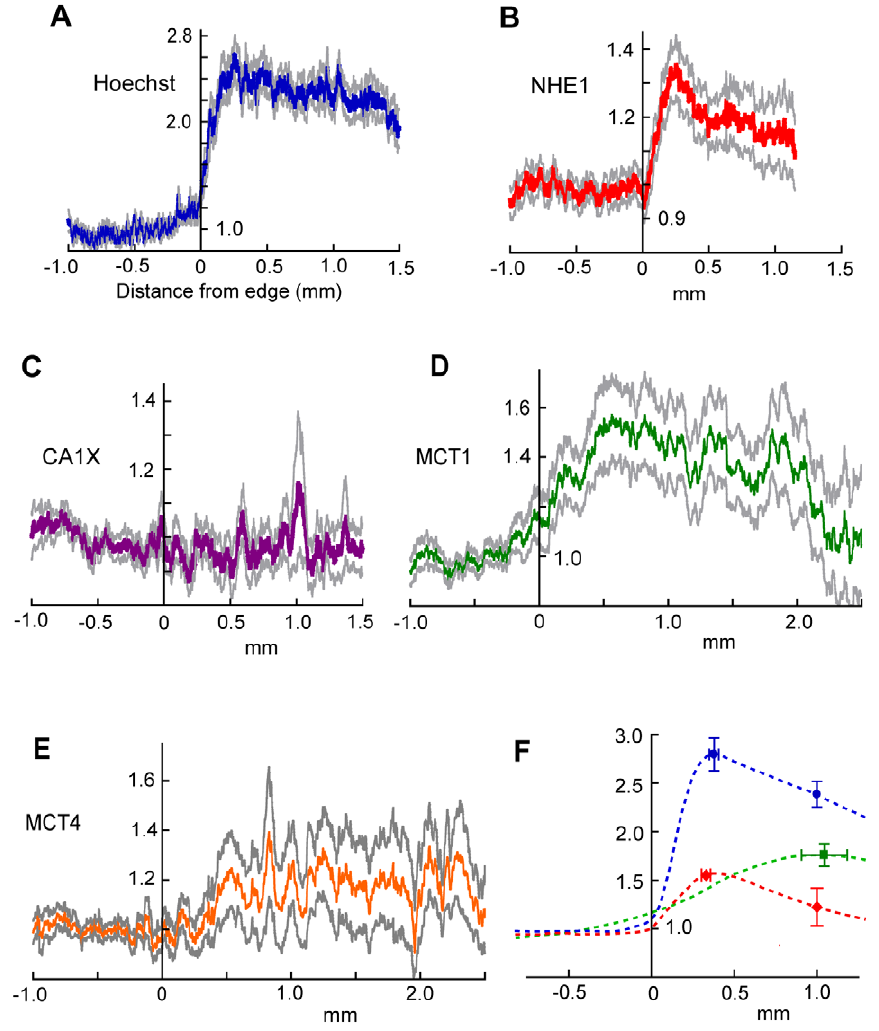
Figure 2. Organization of NHE1 and MCT1 in the tumor rim. (A – E). Labeling intensity (relative to outside the glioma) for Hoechst (average of 27 strips), NHE1 (22), CAIX (22), MCT1 (18) and MCT4 (16). Gray lines are an indication of SEM (see Methods). Note that the ordinate scales are not all the same. (F) Mean relative intensities 6 SEM for peaks (Hoechst, NHE1 and MCT1) and values at 1 mm for Hoechst and NHE1. Schematic curves have been sketched in. The mean values were calculated from measurements on individual profiles and therefore do not correspond exactly with the averaged profiles in (A,B,D).